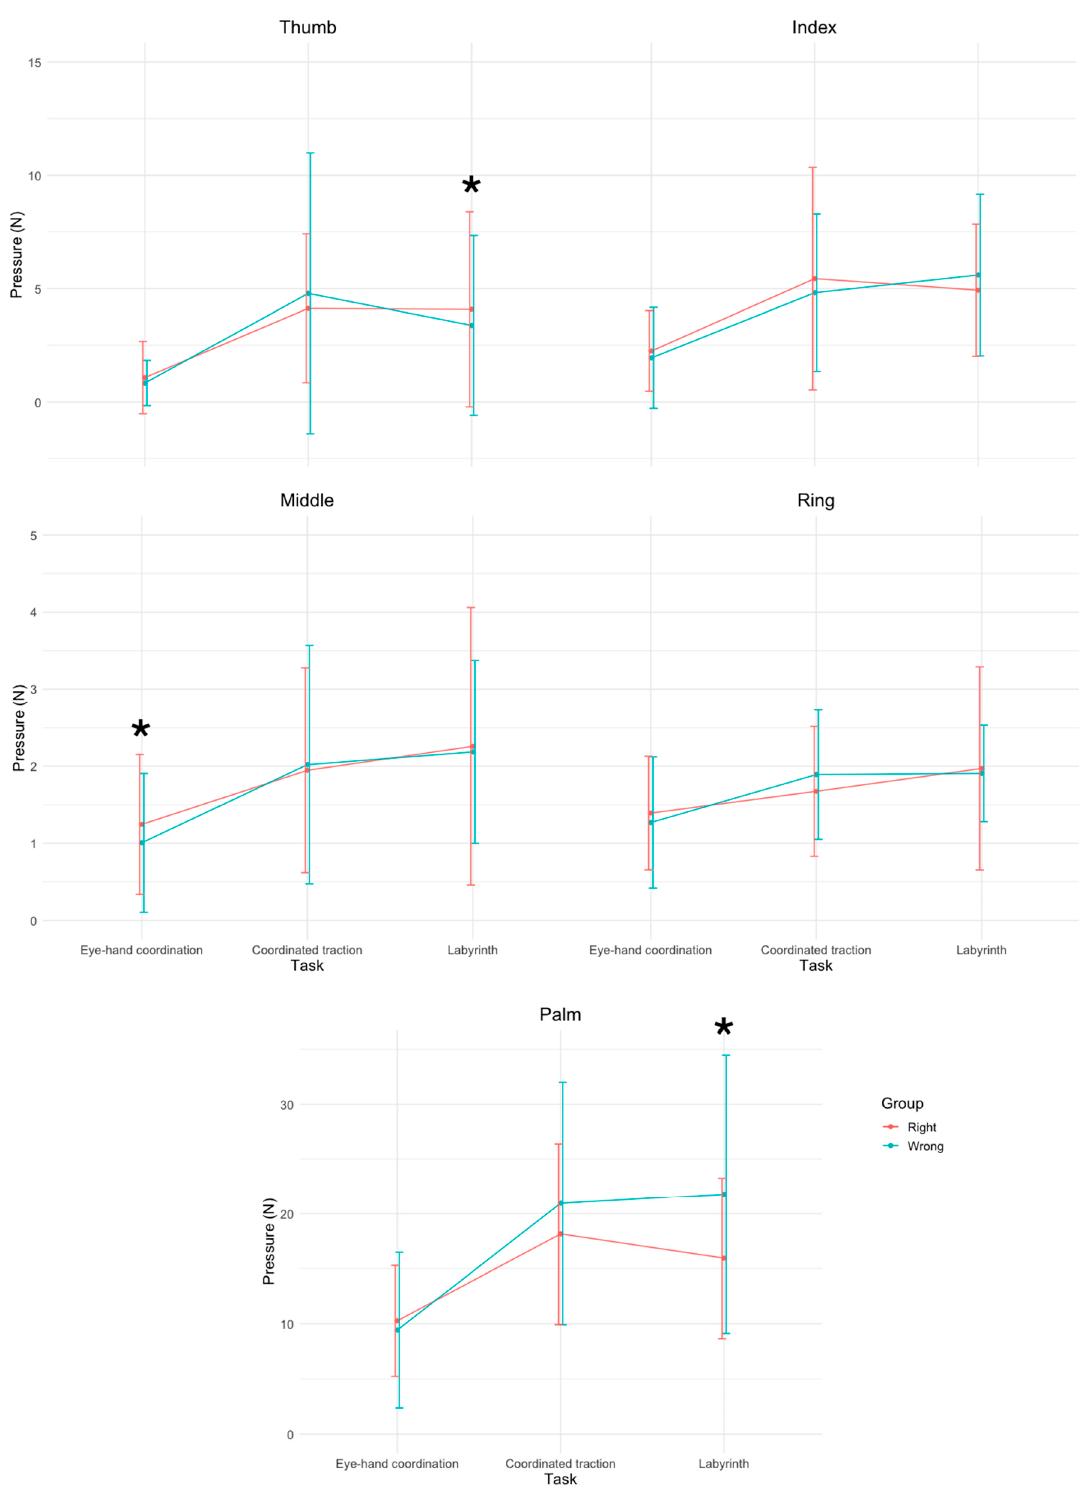
Figure 6. Pressure exerted by the surgeons’ fingers (thumb, index, middle and ring fingers) and palm during the laparoscopic tasks using the right and wrong instrument handle size. The range of pressure values (y axis) has been adapted to each data set. * p < 0.05.